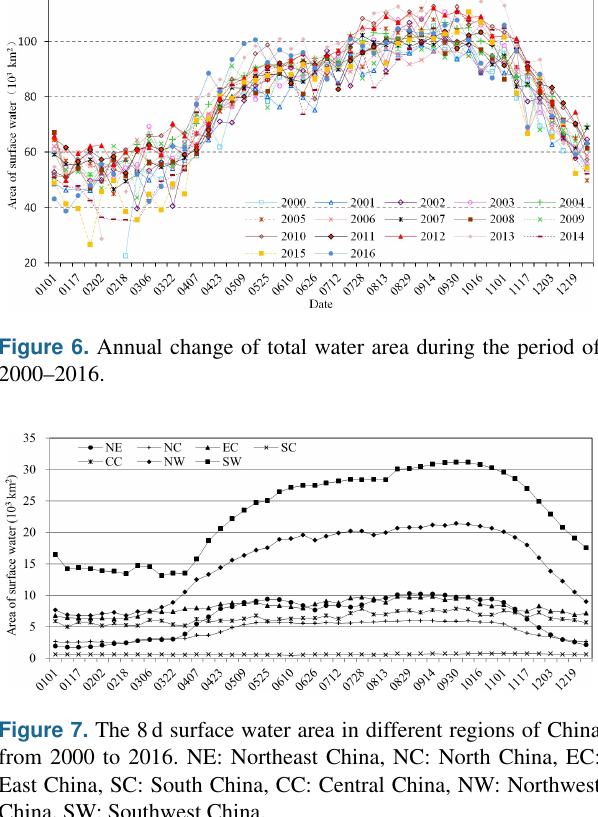
Table 4. The average distribution of surface water area in inland China from 2000 to